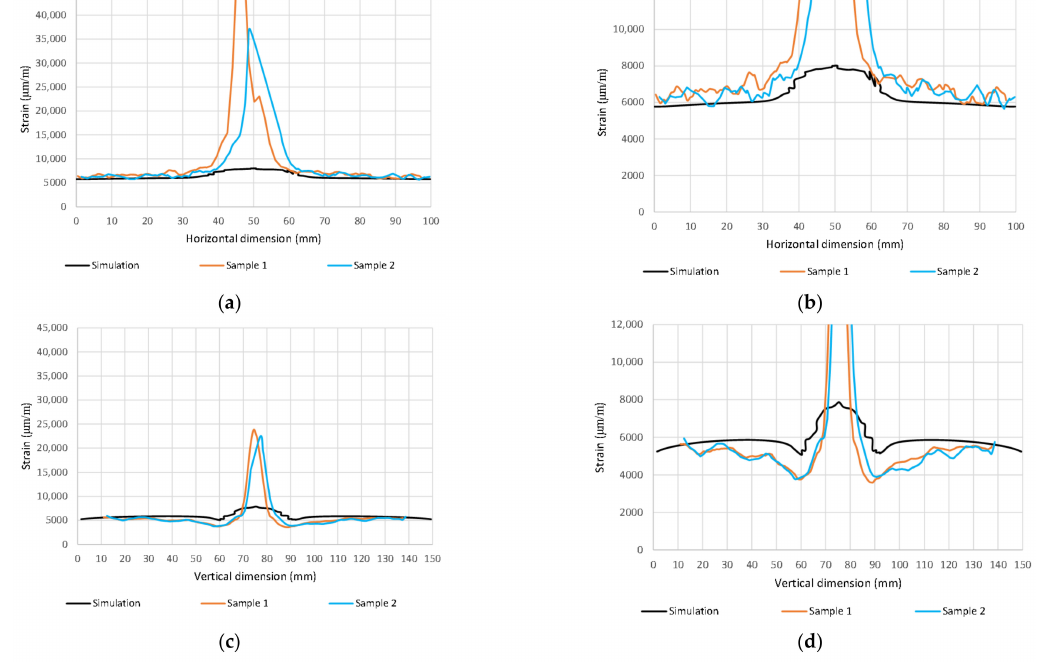
Figure 16. Max. principal strain distribution ( µ m/m) at load 80 kN; ( a ) Horizontal path—scale 1; ( b ) Horizontal path—scale 2; ( c ) Vertical path—scale 1; ( d ) Vertical path—scale